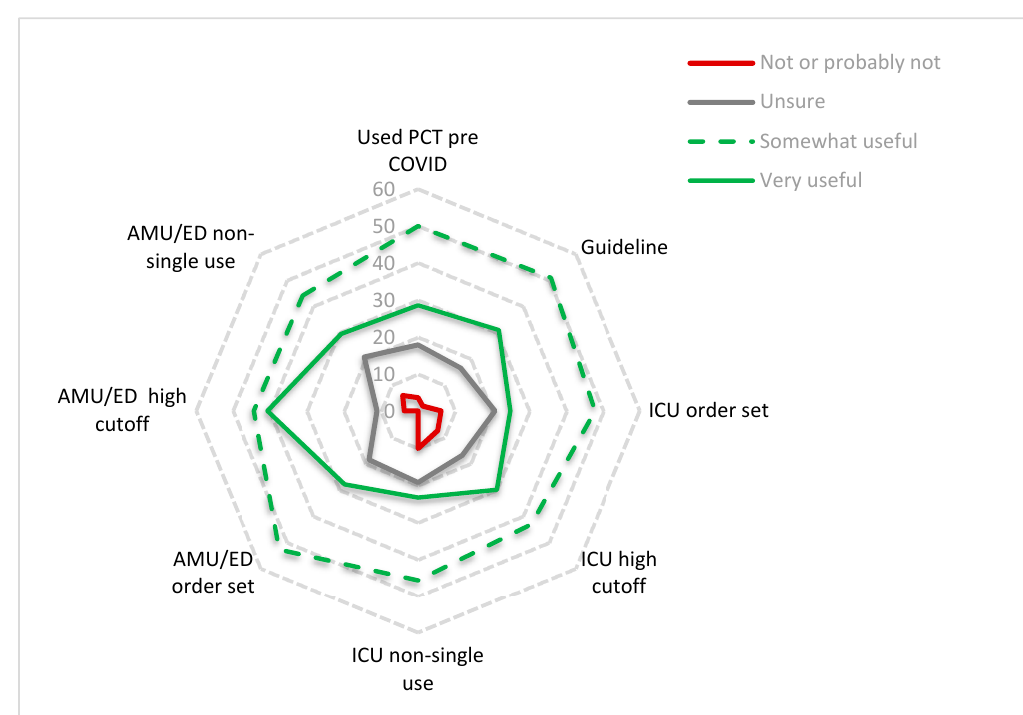
Figure 2. Perceived usefulness of procalcitonin (PCT) in relation to how it was used in practice.